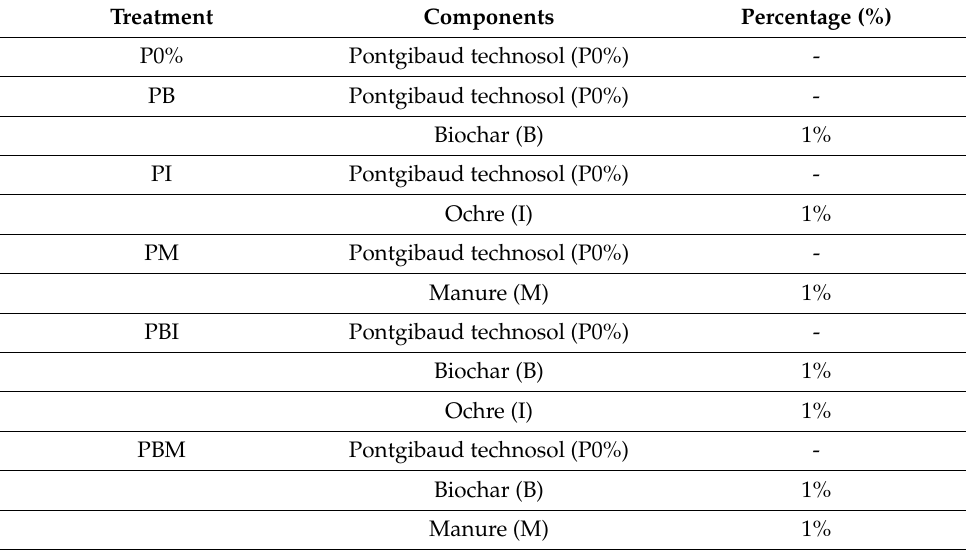
Table 2. Components and their percentage (%) of the eight used treatments (P0%, PB, PI, PM, PBI, PBM, PIM, and